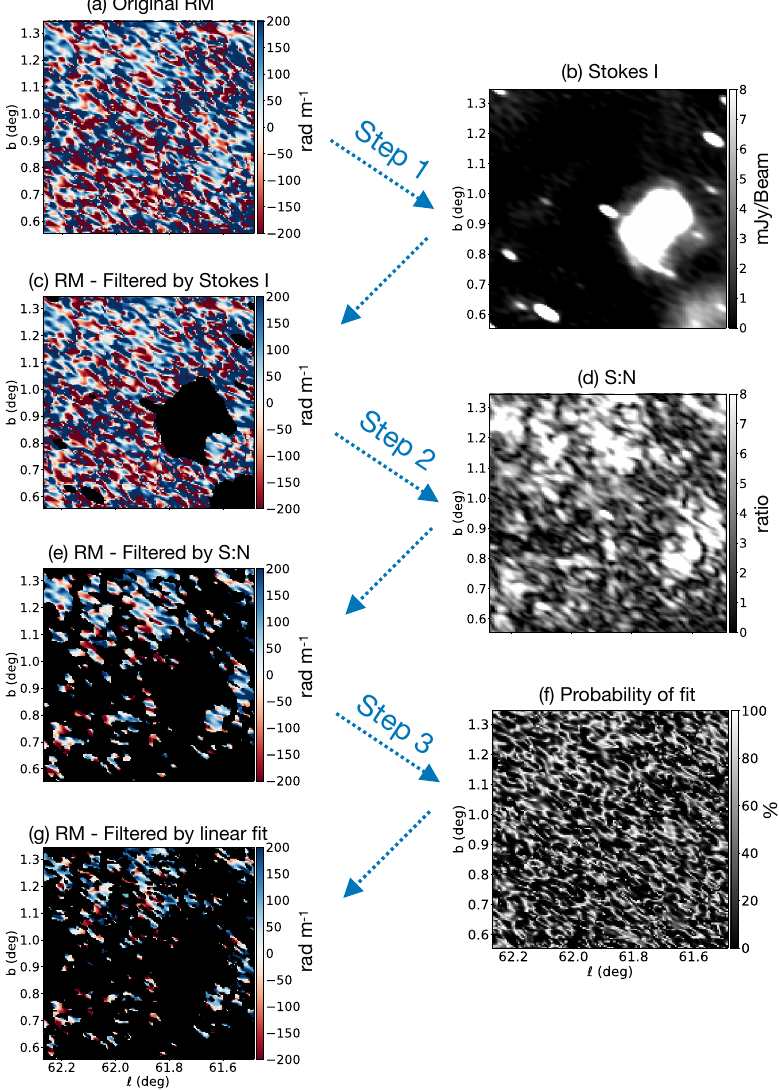
Figure 1. The process by which we filtered the XE RM data, illustrated for a selected region of the CGPS RM image. ( a ) The raw RM values from the linear fit to polarisation angle versus λ 2 . ( b ) The corresponding Stokes I image used in the first processing step. ( c ) The RM map with pixels with Stokes I greater than 3 mJy/beam removed. ( d ) The signal-to-noise map, used in the second processing step. ( e ) The RM map with pixels in polarised intensity below the signal to noise threshold of 5 removed. ( f ) The probability of linear fit used in the third processing step. ( g ) The RM map with pixels with a probability of linear fit less than 10%